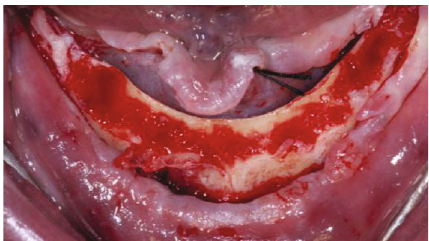
Figure 2: The alveolar ridge after the osteotomy: the fl at surface is necessary for the application of the surgical